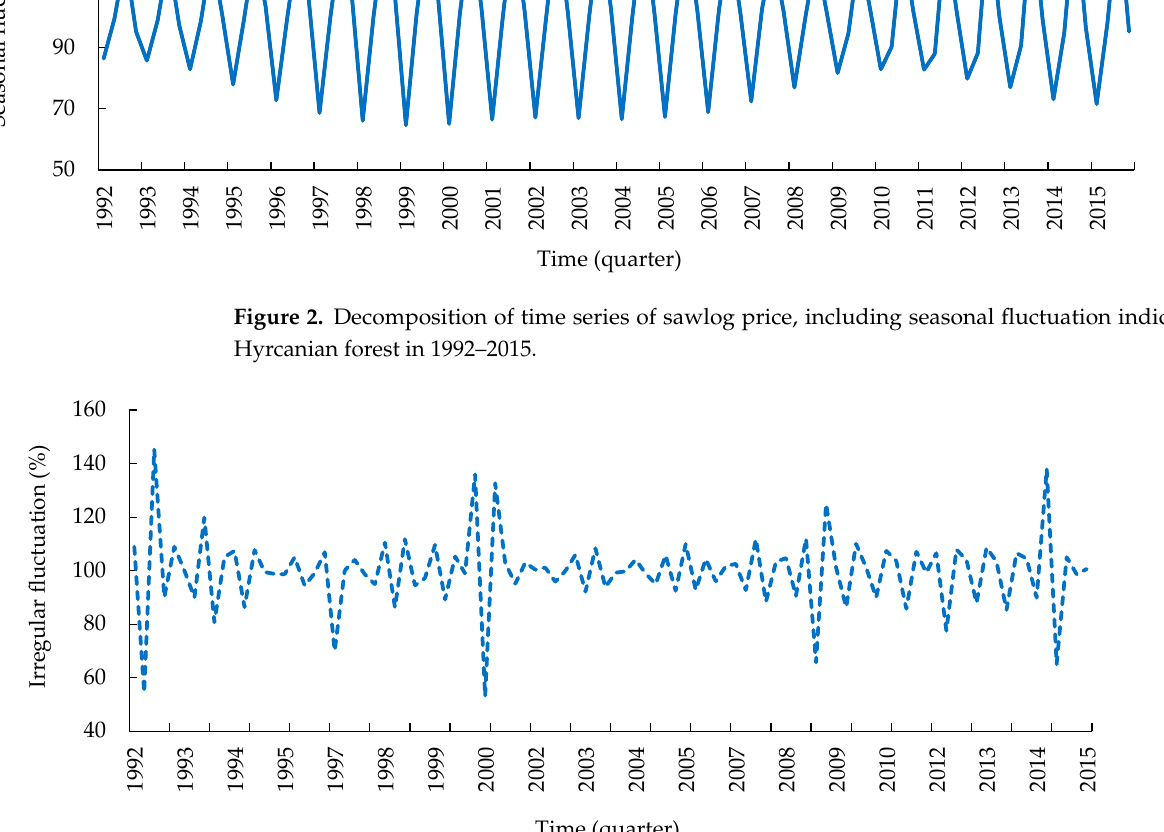
Figure 3. Decomposition of time series of sawlog price, including irregular fluctuation indices in Hyrcanian forest in 1992–2015.